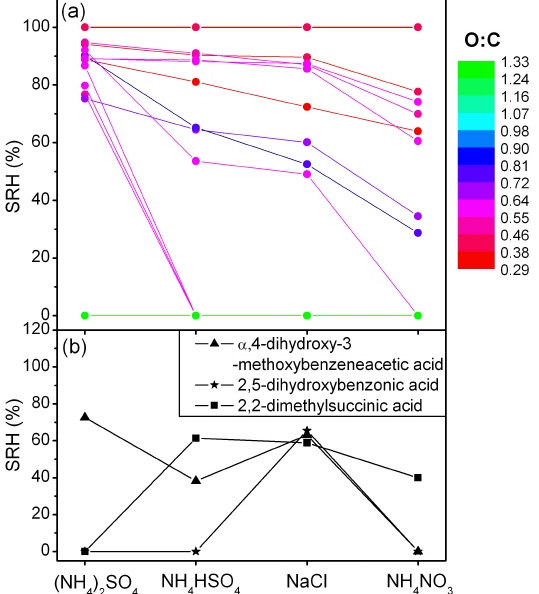
Fig. 4. Summary of trends of SRH of particles (OIR = 2.0 ± 0.1) as a function of inorganic salt type: (a) the SRH of the organics (20 in total) that followed the trend (NH 4 ) 2 SO 4 ≥ NH 4 HSO 4 ≥ NaCl ≥ NH 4 NO 3 and (b) the SRH for 2,5-dihydroxybenzonic acid, α ,4- dihydroxy-3-methoxybenzeneacetic acid, and 2,2-dimethylsuccinic acid. In panel a, colors represent the O:C of individual or- ganics. The organics shown in panel b didn’t follow the trend (NH 4 ) 2 SO 4 ≥ NH 4 HSO 4 ≥ NaCl ≥ NH 4 NO 3 . Uncertainties in the SRH measurements have been left off for